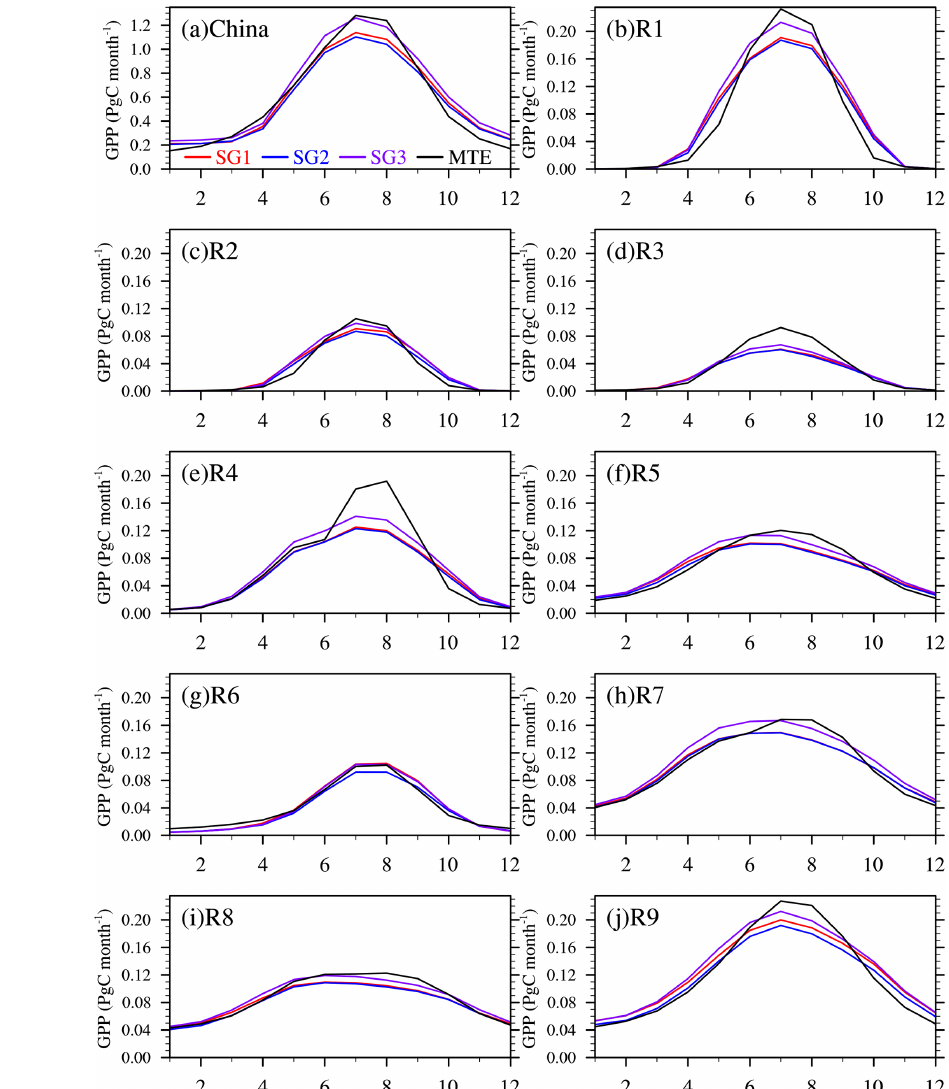
Figure 6. Seasonal variations in GPP of China and each subregion from the ensemble mean of the 12 MsTMIP models for the three simulations (SG1, SG2 and SG3) and the MTE. All the results in this figure are averaged between 1981–2010 for the MsTMIP and 1982– 2010 for the